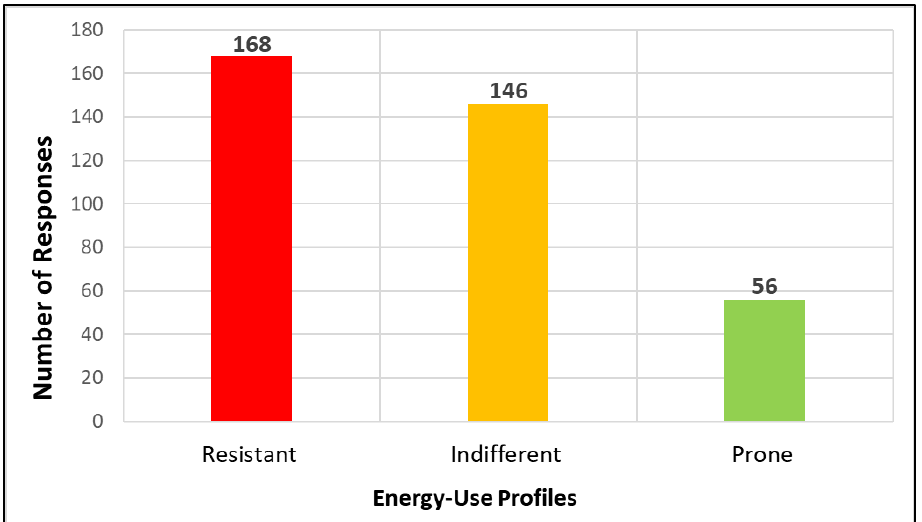
Figure 8. Energy-Use Profiles for Energy-Use Survey Participants.